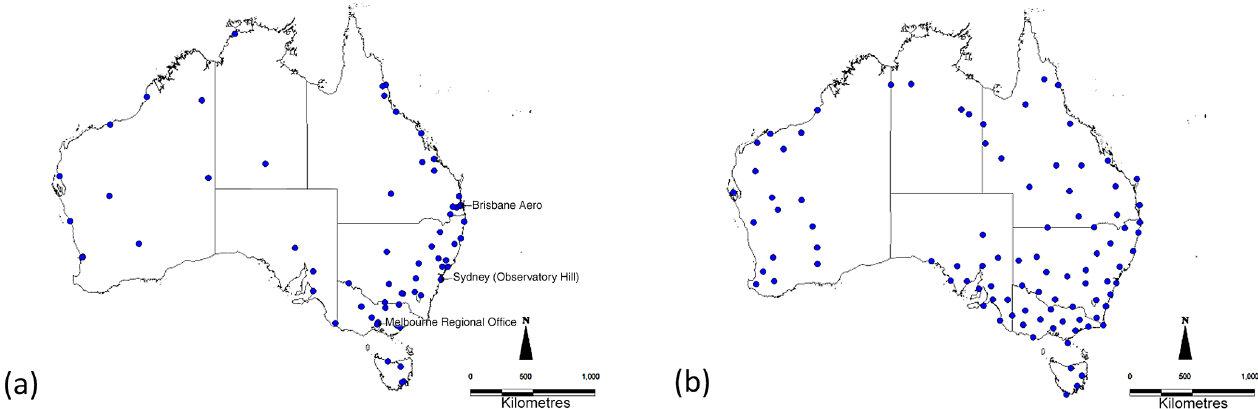
Figure 1. (a) Reference stations for sub-daily rainfall, (b) Reference stations for daily rainfall. Note the three long-term sub-daily stations used in the IFD analysis are also